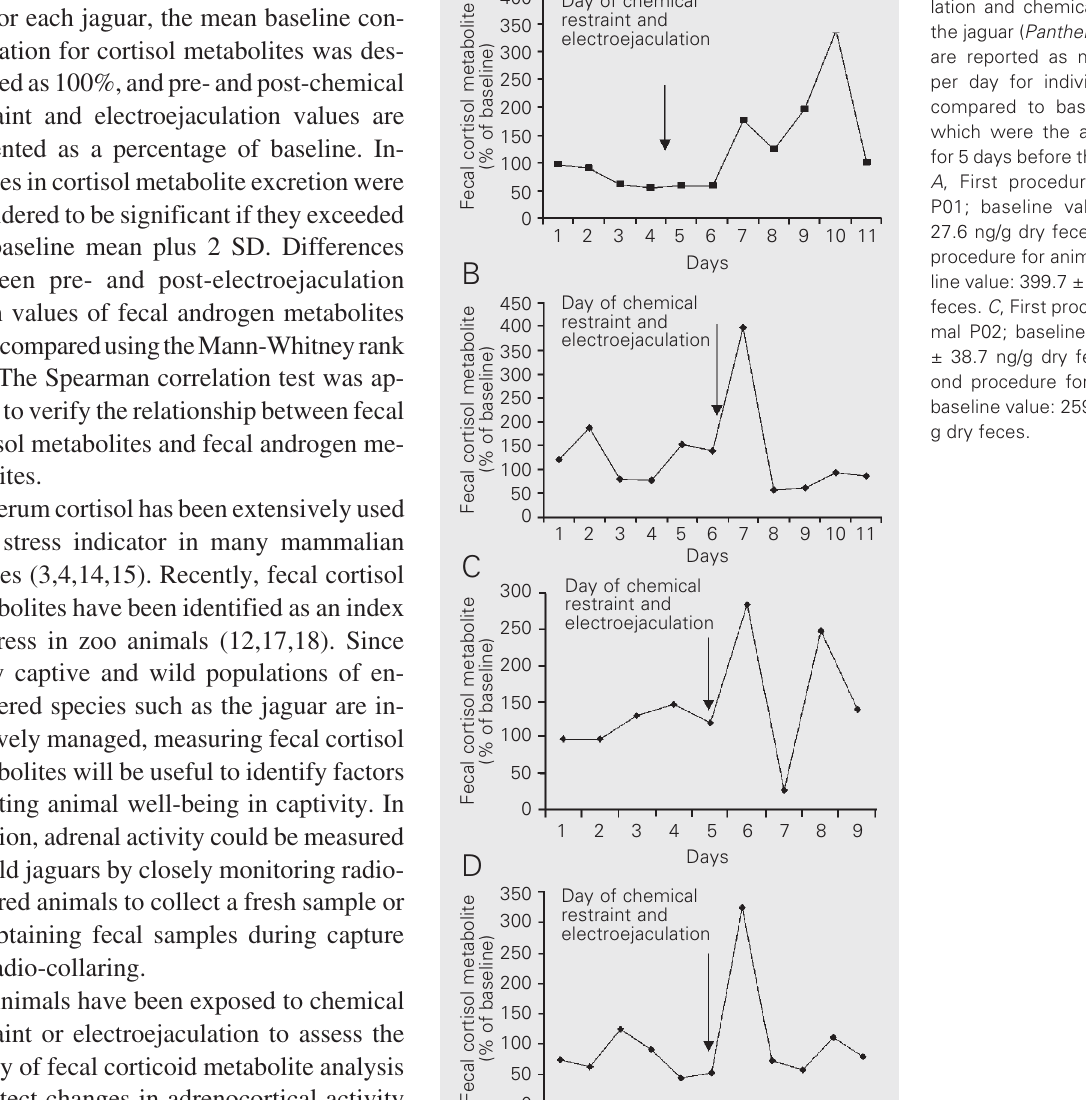
Figure 1. Response of fecal cor- tisol metabolite to electroejacu- lation and chemical restraint in the jaguar ( Panthera onca ). Data are reported as mean percent per day for individual animals compared to baseline values, which were the average value for 5 days before the